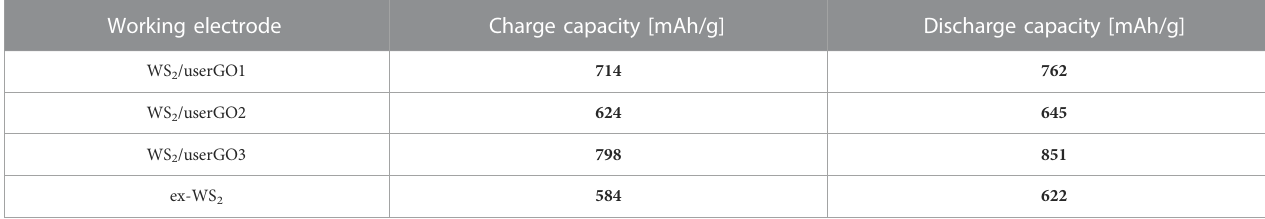
TABLE 1 Initial charge/discharge capacities of electrodes examined at 0.05 A/g. Working electrode